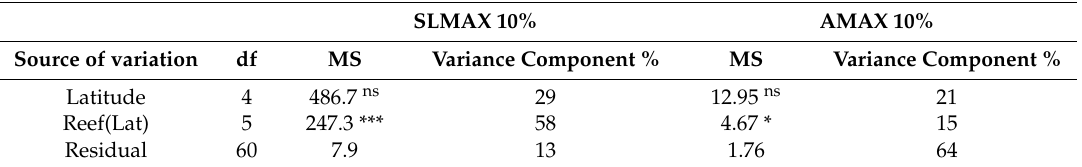
Table 4. Results of Analysis 2, a nested ANOVA, testing for di ff erences among five latitudes with two reefs nested per latitudes ( n = 7); dependent variables were standard length top 10% and age top 10%. Variance components describe the variation contributed to each factor as a percentage. The denominator MS for latitude is Reef (Lat) and that of Reef (Lat) is the residual; * p < 0.05; *** p <